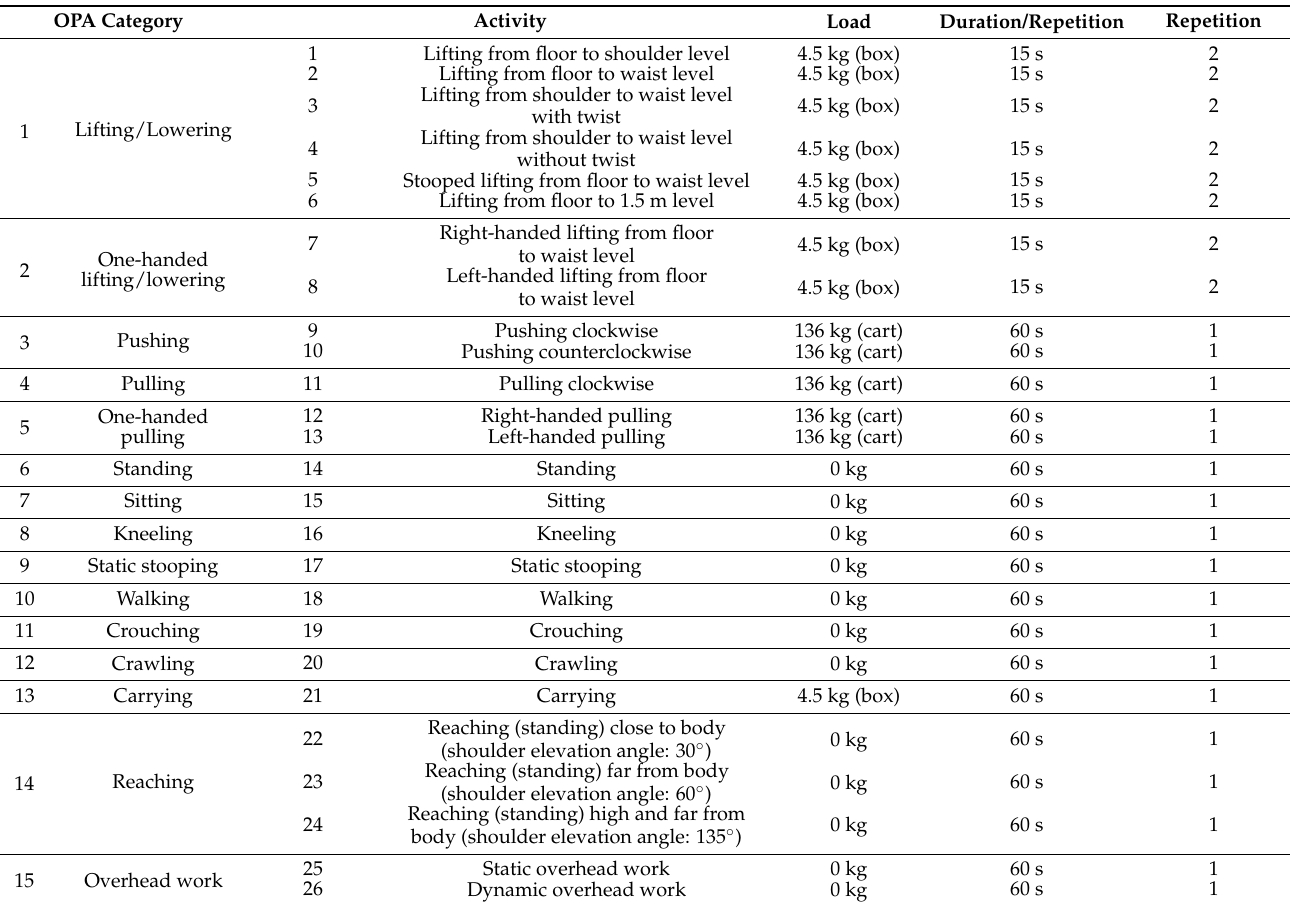
Table 1. Occupational physical activities ( N of subjects = 15).